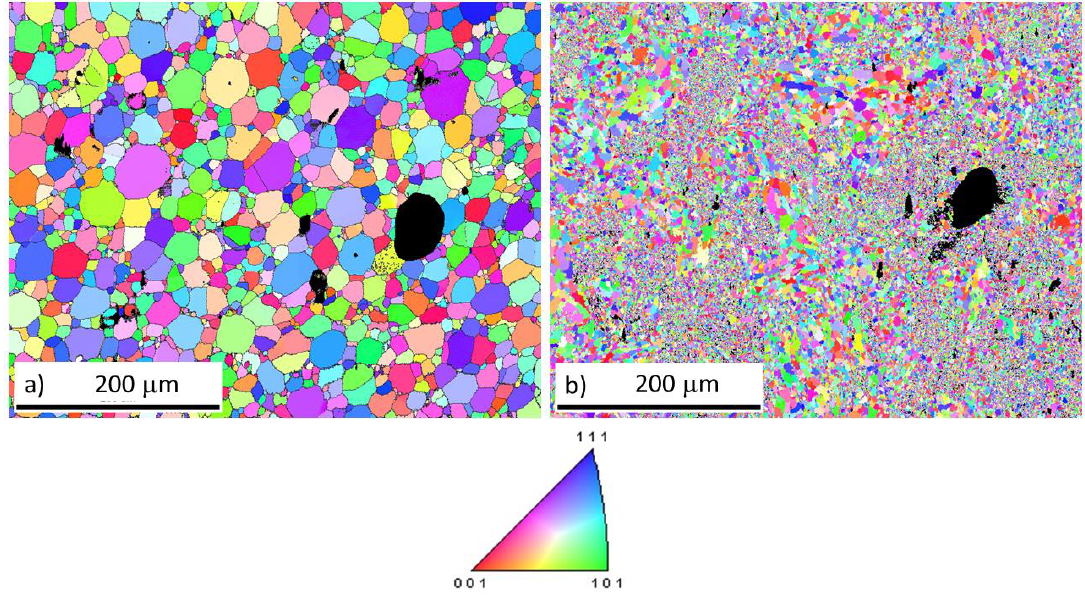
Figure 7. EBSD orientation maps of Fe28Al SPS compacted at 1100 °C sintered from ( a ) the initial and ( b ) the 1-h milled powder.